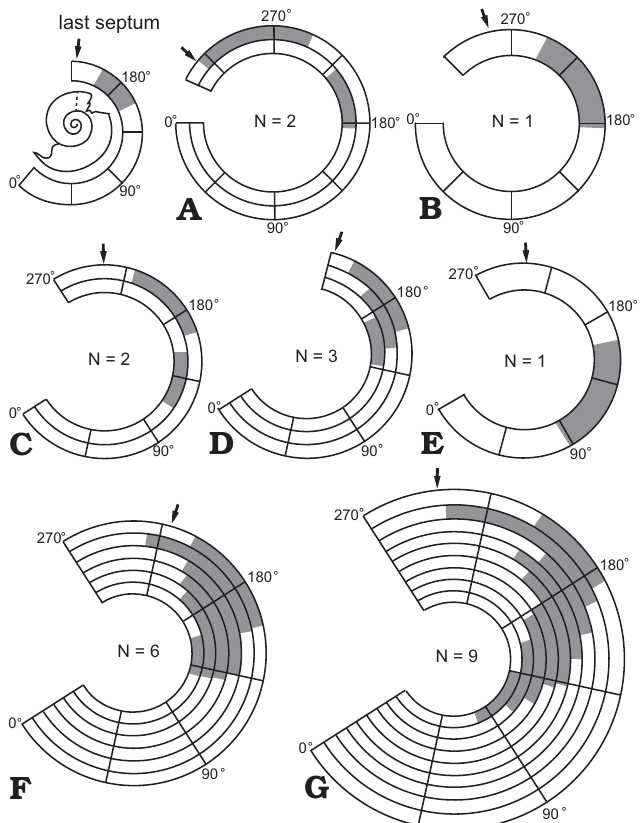
Fig. 6. Position of ventral breakage in the shells of seven early Toarcian ammonoid genera. Specimens whose position of the aperture is uncertain are excluded. Arrows indicate the average of the estimated position of last septum. The living orientation of the shells is based on Westermann (1996). A . Dactylioceras . B . Fontanelliceras . C . Fuciniceras . D . Proto- grammoceras . E . Paltarpites . F . Harpoceras . G . Cleviceras